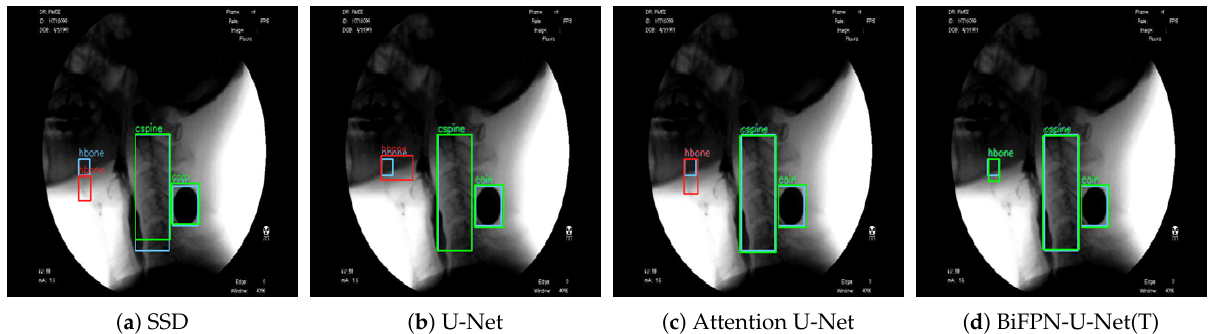
Figure 4. Detection results of each method when the hyoid bone overlaps with the mandible. The blue box denotes the ground truth, the green box denotes true positives, and the red box denotes false